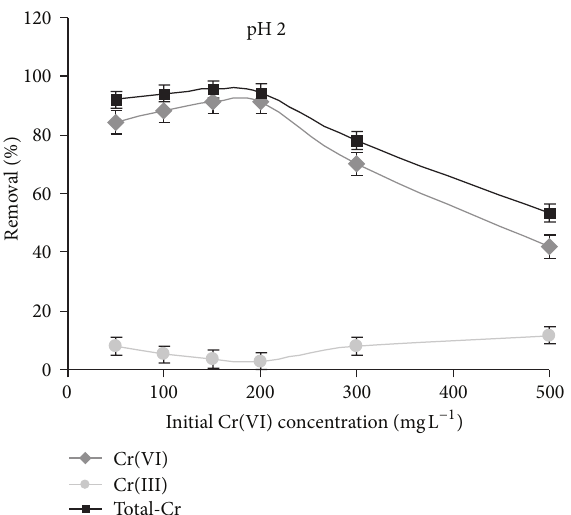
Figure 2: Removal of chromium by micelle-clay complex as total- Cr determined by AAS ( ◼ ) and as Cr(VI) determined by UV-vis method ( Q ). Percent of Cr(VI) reduction to Cr(III) ( ∙ ) is calculated as the difference between total-Cr and Cr(VI) percentages. pH = 2, contact time = 3 h, temperature = 25.0 ± 0.2 ∘ C, and adsorbent dosage = 5.0 gL −1 . Data represent averages of triplicates ± SE. Table 1: Initial and final pH during adsorption of Cr(VI) either on pure clay or micelle-clay complex. Initial concentration of Cr(VI)